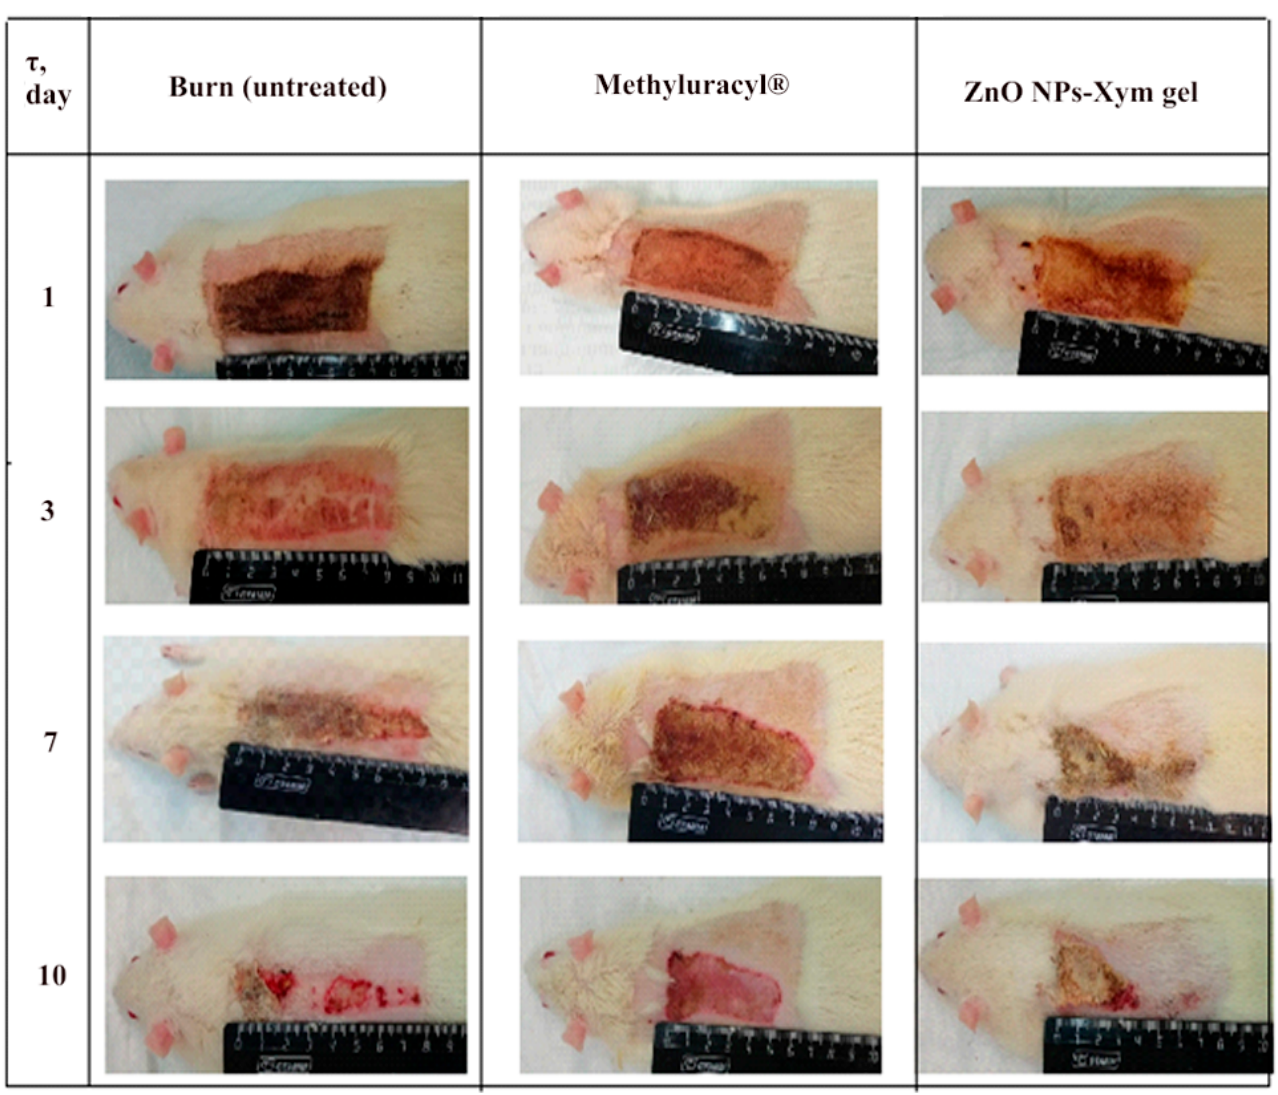
Figure 8. Photos of burn wound on rats under treatment with methyluracyl and ZnO NPs–Xym for 1, 3, 7, and 10 Days.